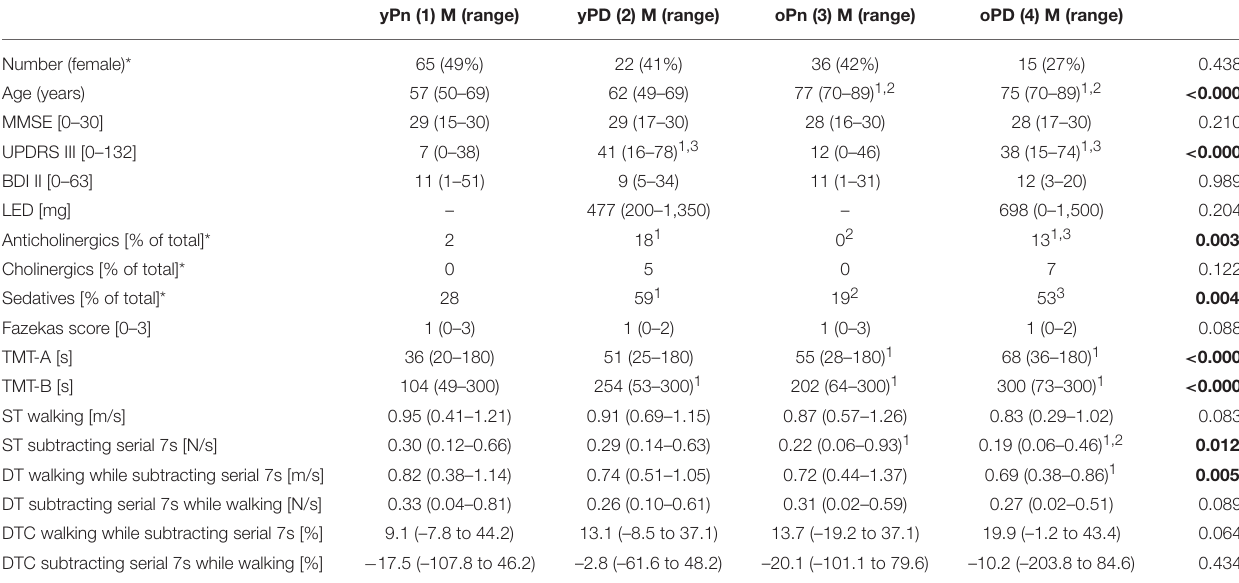
TABLE 1 | Demographic and clinical